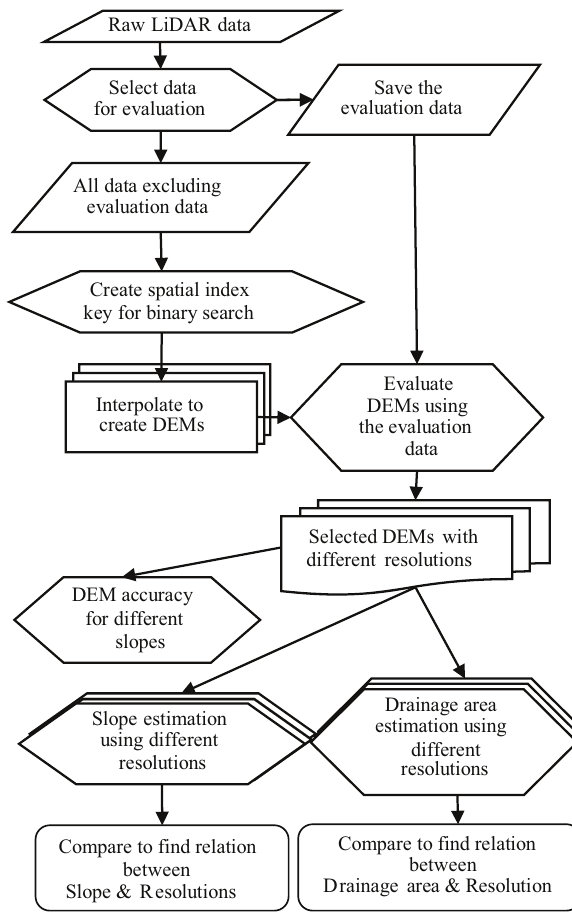
Fig. 1. General process used for the generation and evaluation of the DEM in relation to the interpolation parameters, model resolution, and the estimates of terrain slope and drainage